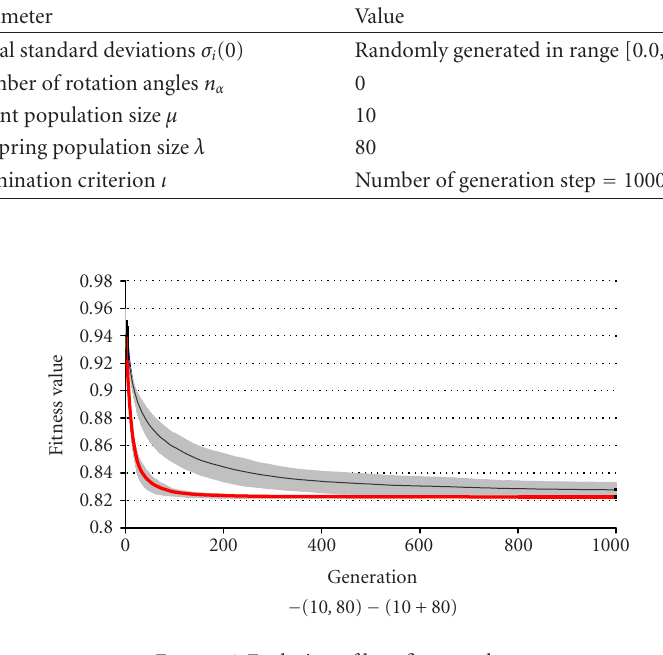
Figure 6: Evolution of best fitness